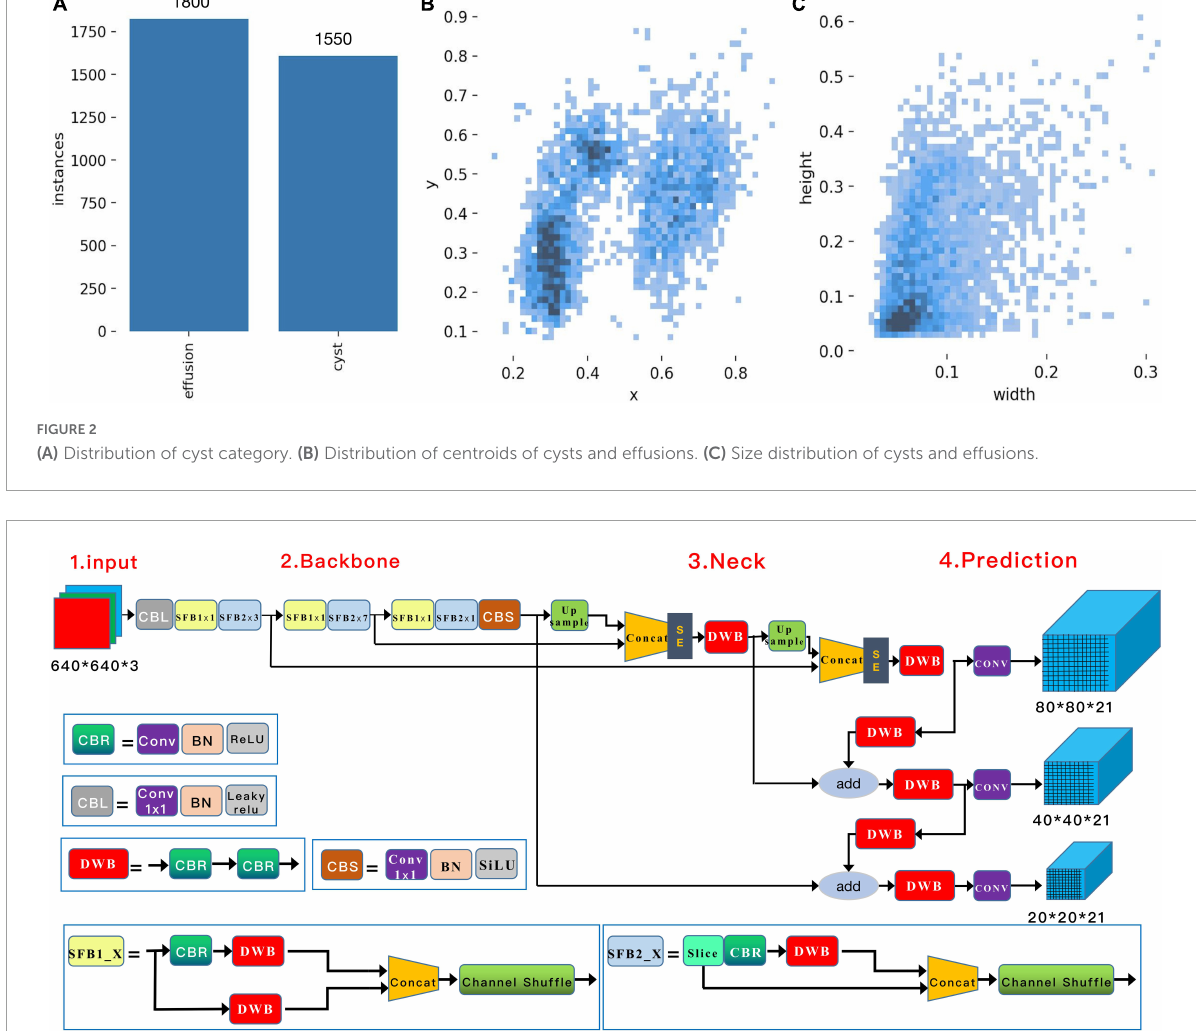
FIGURE3 SE-YOLOv5 model architecture for cyst